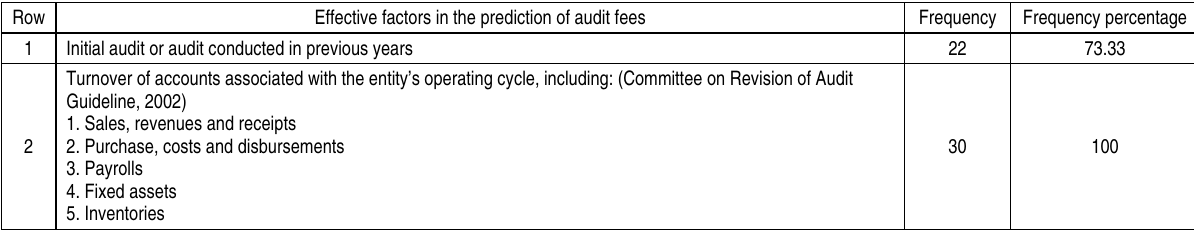
Table 3. Factors influencing the prediction of audit